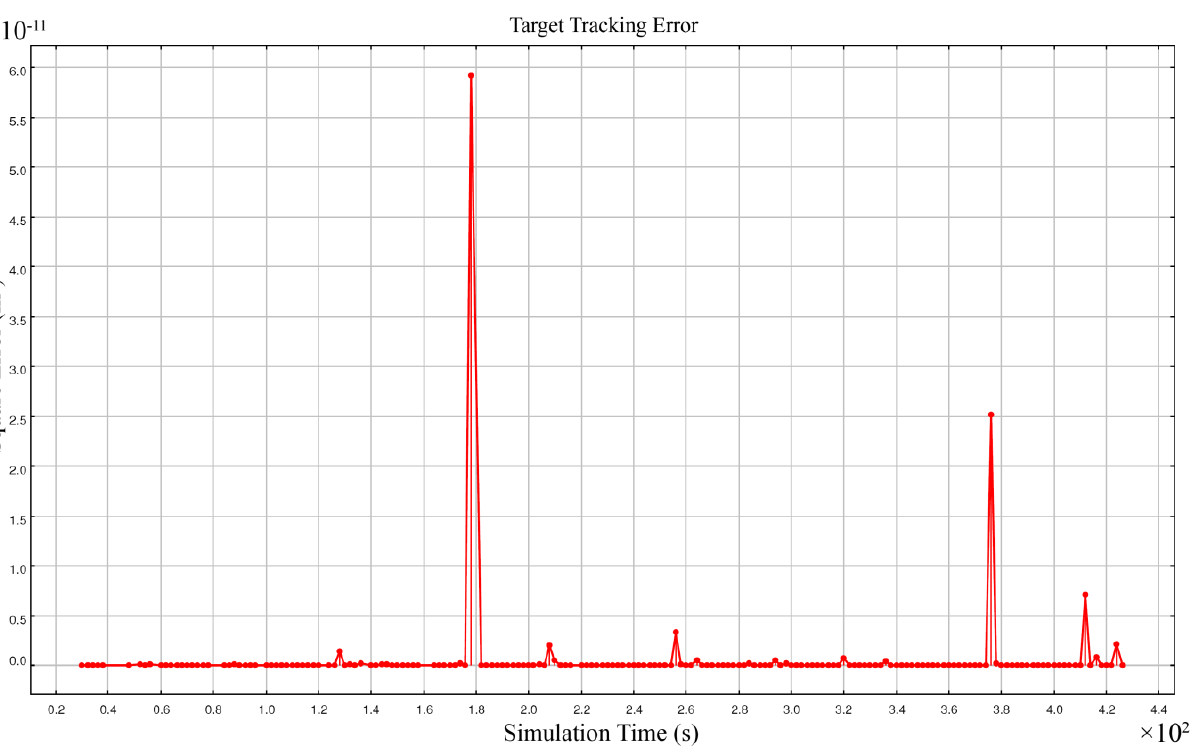
Figure 12. Square error of 3-dimensional target tracking using FCRAL